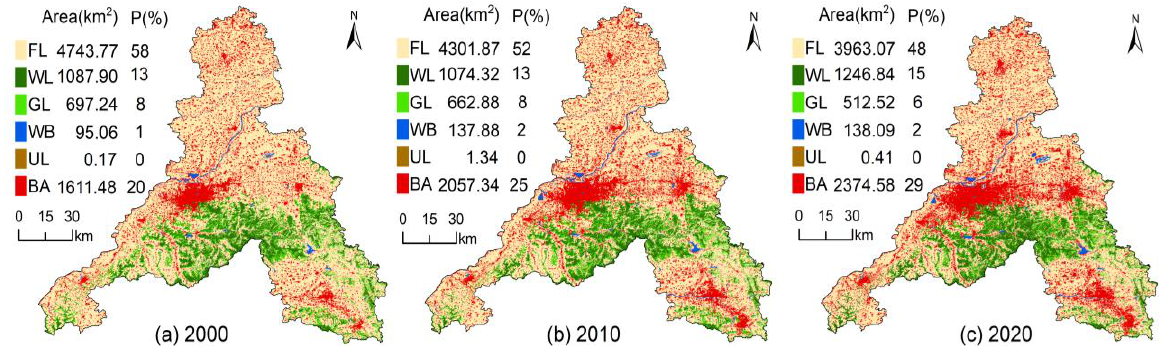
Figure 3. Classification results of land use/land cover in Jinan City: ( a ) is the land use/land cover structure and spatial distribution in 2000; ( b ) is the land use/land cover structure and spatial distribution in 2010; and ( c ) is the land use/land cover structure and spatial distribution in 2020.